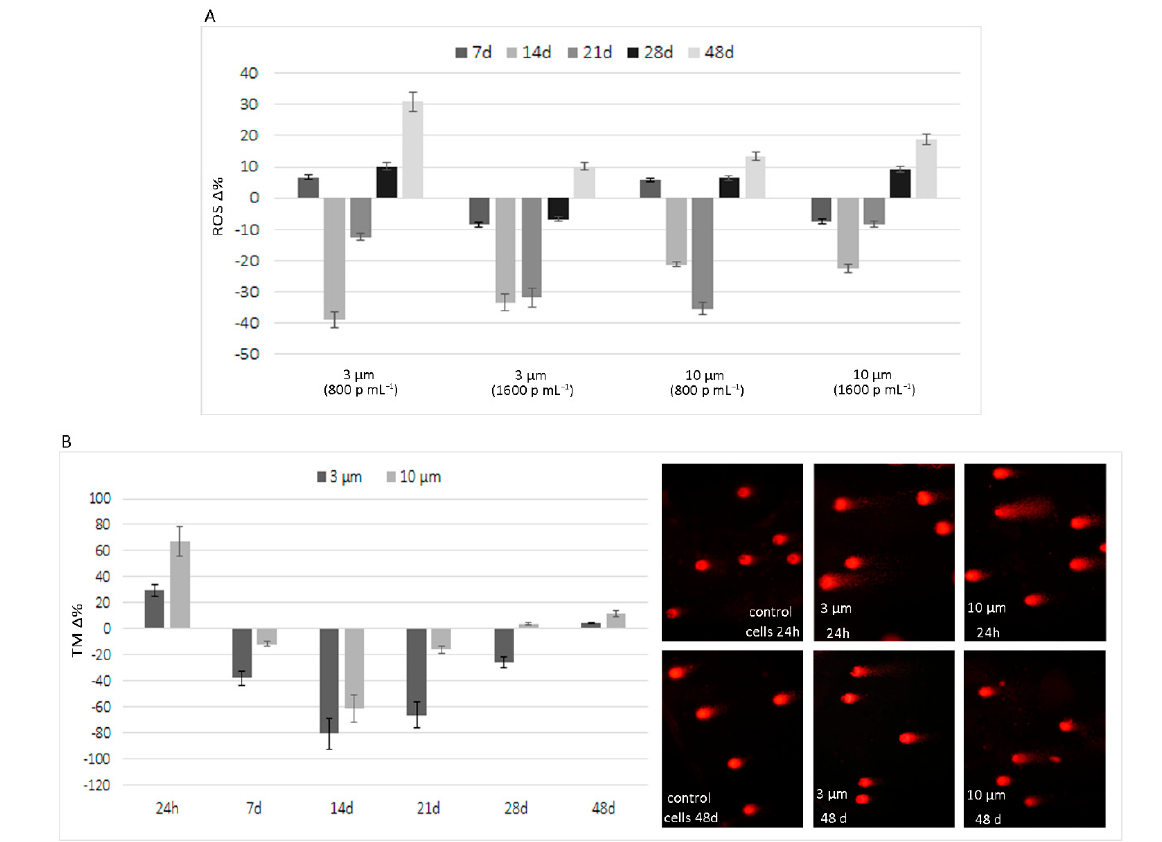
Figure 3. Effects of sub-chronic exposure in PS- MPs treated cells. ( A ) ∆ % of ROS production in comparison to untreated cells after 7, 14, 21, 28, and 48 days. The graph highlights the ability of HT-29 to neutralize, albeit temporarily, the pro- oxidant effect of PS-MPs. ( B ). Results of Comet assay expressed as ∆ % of tail moment ™ in comparison to untreated cells. Short-term treatment (24 h) caused a highly fragmented DNA in cells exposed to 3 and 10 µm PS-MPs (1600 p mL − 1 ) which was suppressed in the intermediate time points and then only partially reappeared after prolonged exposure, showing the same trend of ROS production. On the right are shown representative images of Comet assay in control and PS-MPs treated cells after 24 h and 48 days.